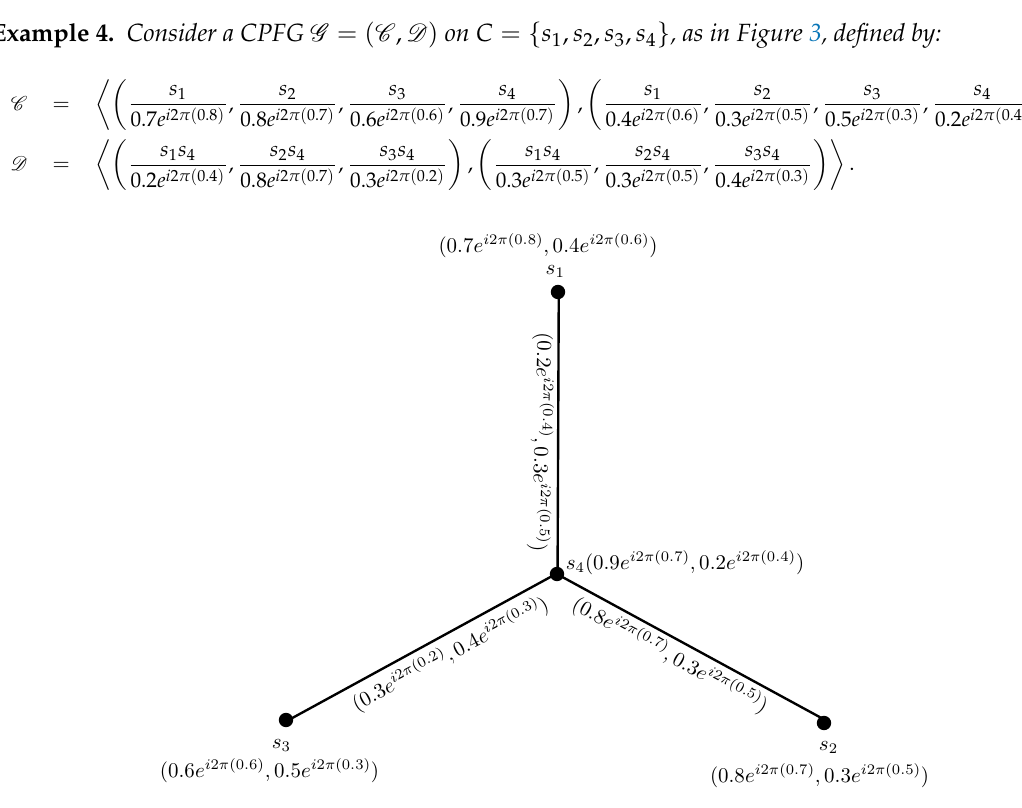
s 2 Figure 4: Complement of a complex Pythagorean fuzzy graph. It is easy to see from Fig. 4 that G = ( C , D ) is a CPFG. 117 Theorem 2.1. The complement of a complement of CPFG is a CPFG itself i.e., G = G . 118 Proof. Suppose that G is a CPFG. Then by utilizing the Def. 2.5, we have µ C ( r ) e iα C ( r ) = µ C ( r ) e iα C ( r ) = µ C ( r ) e iα C ( r ) and ν C ( r ) e iβ C ( r ) = ν C ( r ) e iβ C ( r ) = ν C ( r ) e iβ C ( r ) f or all r ∈ C. If µ D ( rs ) e iα D ( rs ) = ν D ( rs ) e iβ D ( rs ) = 0, then 119 µ D ( rs ) e iα D ( rs ) = µ C ( r ) ∧ µ C ( s ) e i ( α C ( r ) ∧ α C ( s )) = ( µ C ( r ) ∧ µ C ( s )) e i ( α C ( r ) ∧ α C ( s )) = µ D ( rs ) e iα D ( rs ) , 5